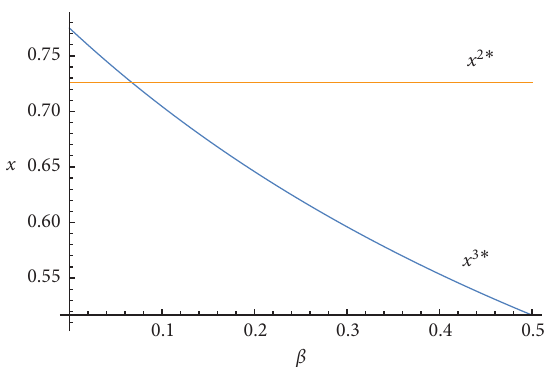
Figure 5: Effects of β on the optimal discount rate for presales.